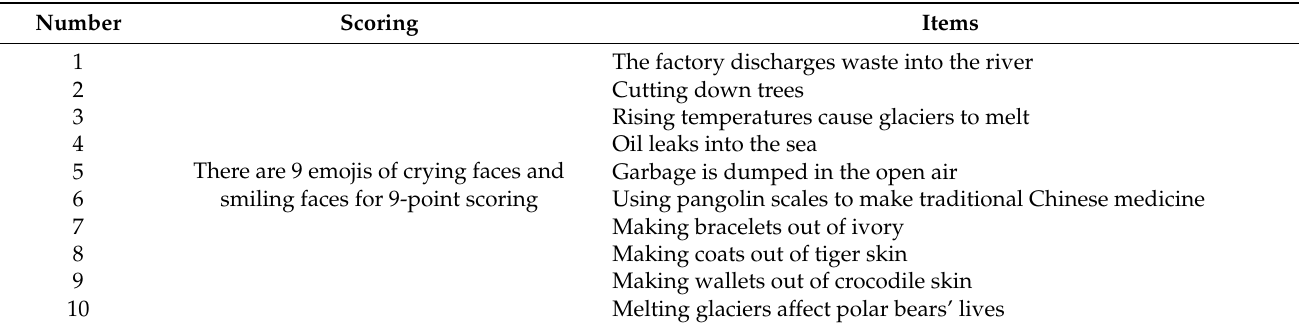
Table A4. The scale of children’s environmental